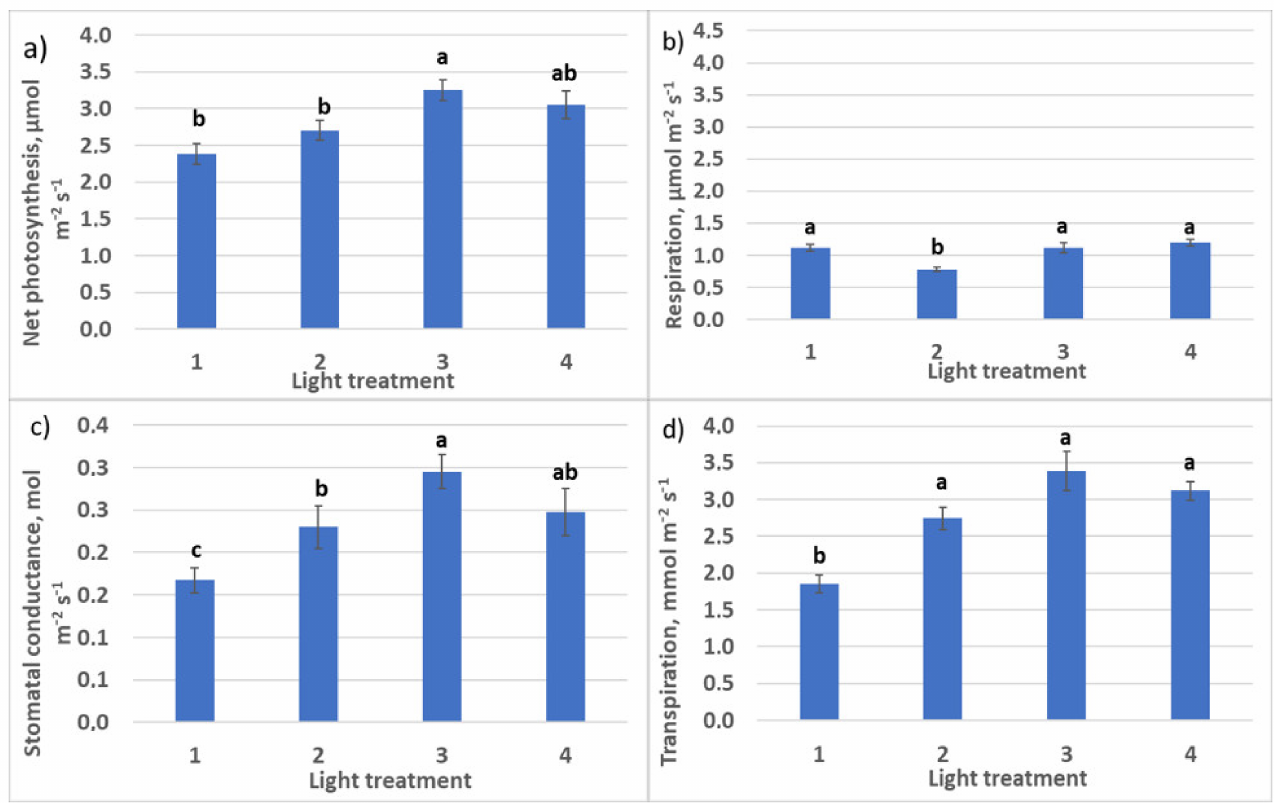
Figure 4. CO 2 –H 2 O leaf exchange in raspberry plants as affected by different red (R 660 )–far-red (FR)light ratio 30 days after transplanting: ( a ) net photosynthesis; ( b ) respiration rate; ( c ) stomatal conductance; ( d ) transpiration rate. Means ± standard error (SE); means followed by the same letter were not different at p ≤ 0.05. Treatment 1—0% R 660 + 100%